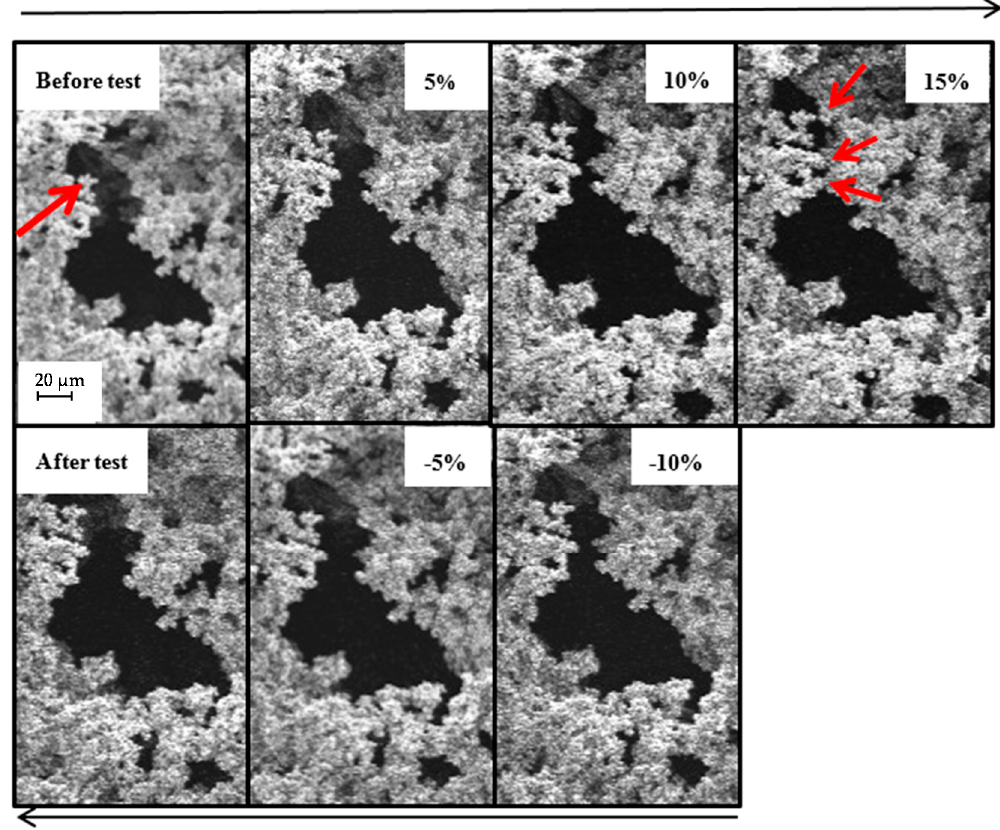
Figure 9. In-situ compression test in SEM of the low-flexible carbon aerogel. Sample was compressed until 15% of initial width and unloaded. The red arrows show the area of most visible deformation during test. A closing of the pore in the upper part and reopening after unloading can be observed.